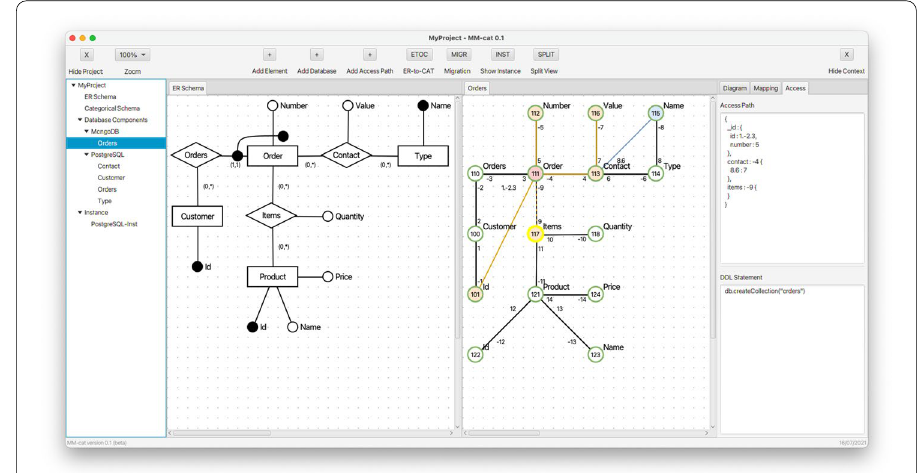
Fig. 13 Sample screen shot of